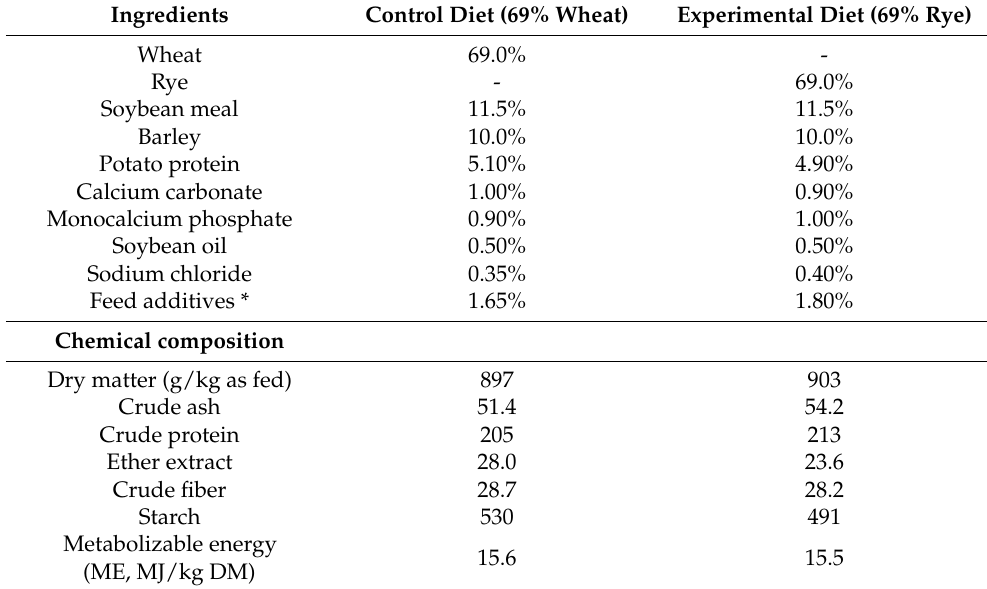
Table 1. Ingredients and chemical composition of compound feeds (g/kg dry matter